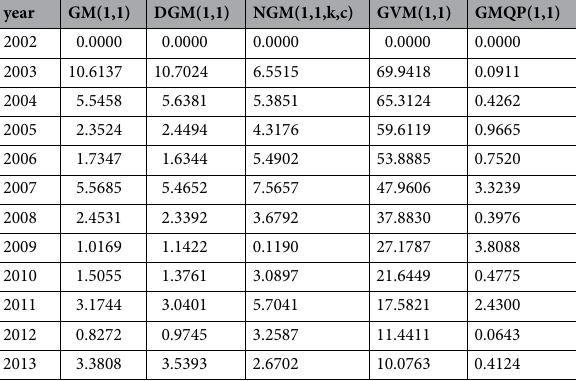
Table 6. The APEs of these grey models in the electricity consumption in China.